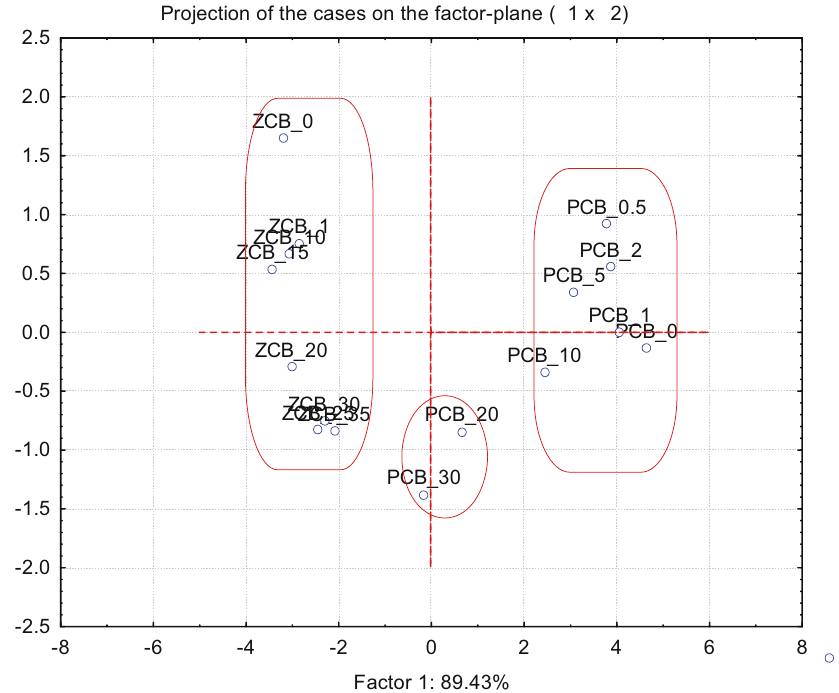
Figure 4: Projection of 16 cases on the plane described by factor 1 vs factor